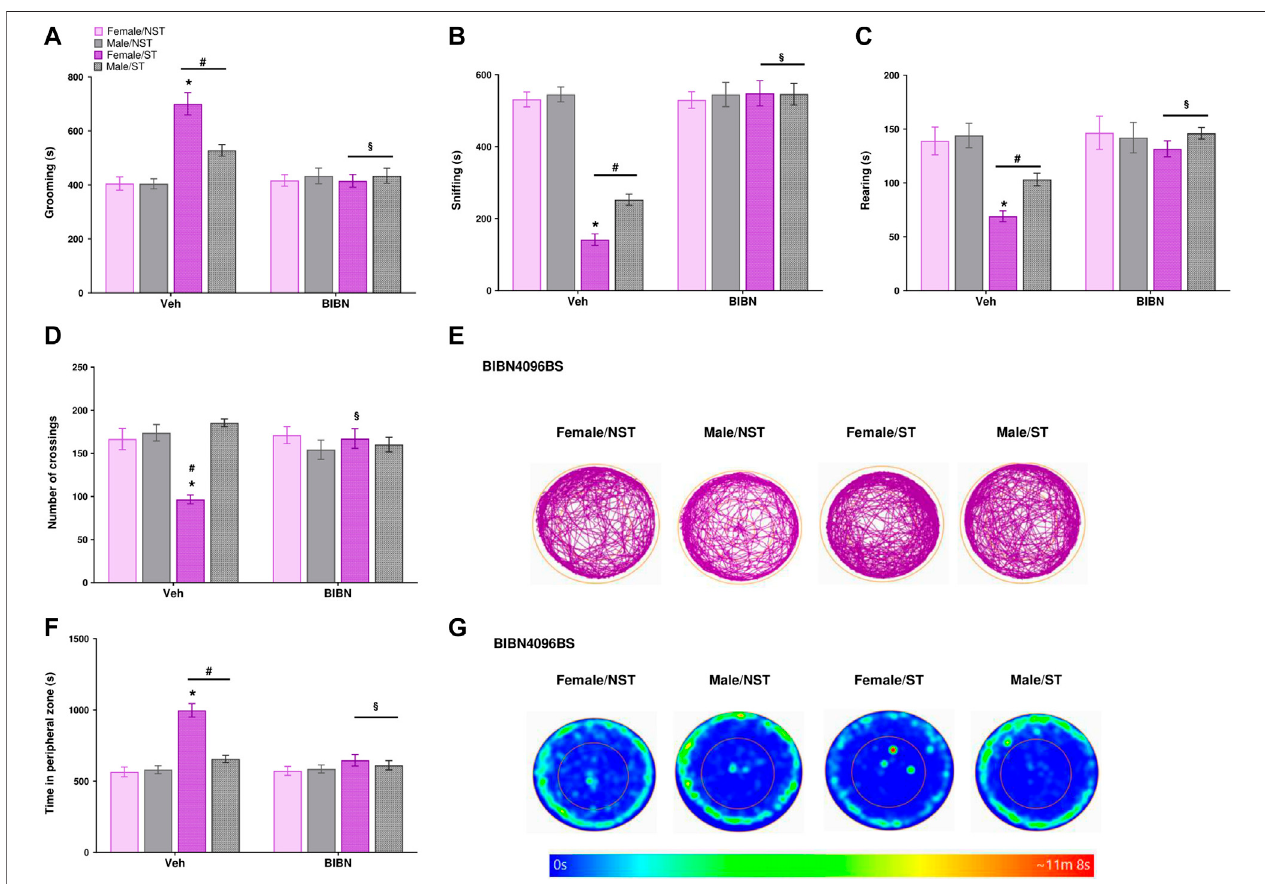
FIGURE 6 | CGRP antagonist reverts the anxiety-like symptoms and increased exploratory activity after unpredictable sound stress. BIBN4096BS (olcegepant, 100 mg/kg)intraperitoneal(i.p.)administrationrevertedthealterationsofdifferentbehavioralparameters:Timespent (A) grooming (B) snif fi ng (C) rearing (D) thenumber of crossings (E) representative image of crossings represented by track plot (F) time in the peripheral zone were observed in the open fi eld test at day 7 post-stress (ST group) orinnon-stressedgroup(NST)1hour-post BIBN4096BS administration. (G) Representativeimage oftime intheperipheralzonerepresentedbyheatmap. Dataareexpressedasmean±S.E.M.( n =8).* p < 0.05,whencomparedbetweenthesexeswithintheSTgroup. # p < 0.05whencompared totheNSTgroup. § p < 0.05 when compared to the vehicle (Veh) treated group [repeated measures two-way ANOVA followed by Bonferroni ’ s post hoc test].